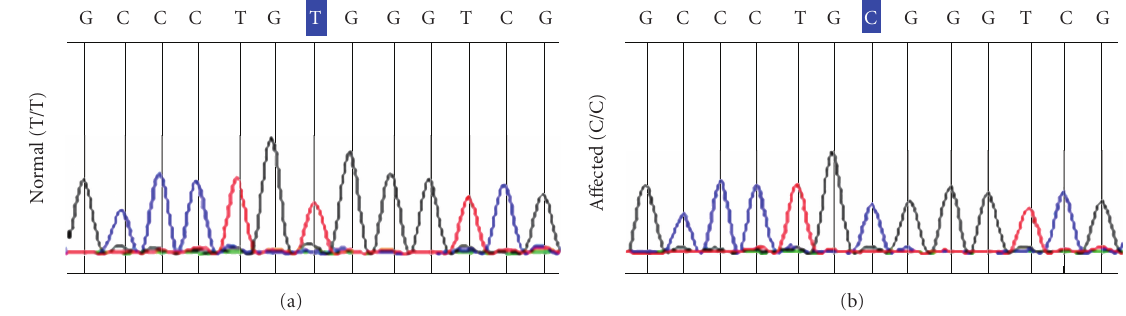
Figure 3: Partial nucleotide sequence of exon 7 of CLN6 in a normal dog and in the a ff ected Australian Shepherd illustrating the c.829T > C mutation.